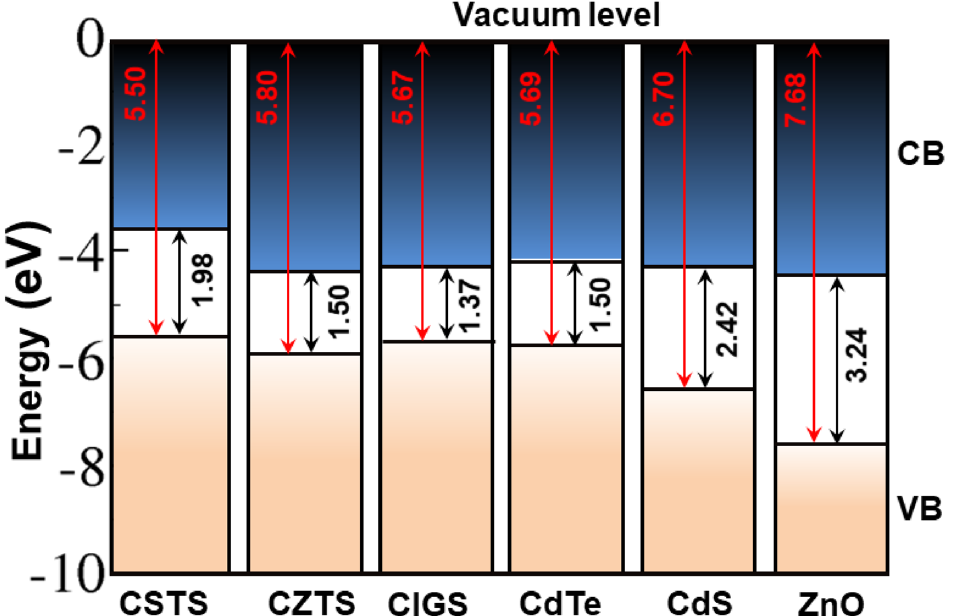
Figure 7. Vacuum-aligned band diagram between CSTS and other common absorbers (CZTS, CIGS, CdTe) and the common n-type partner materials (CdS, ZnO). Literature values of IP and band gap are taken for CZTS 62 , CIGS 63 , CdTe 64 , CdS 62 , and ZnO 65